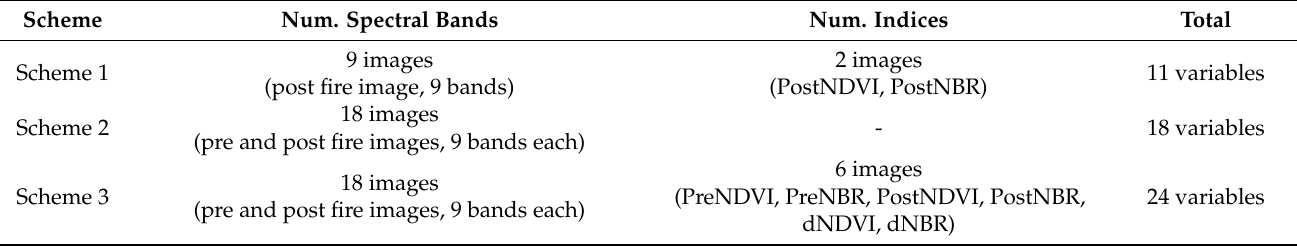
Table 3. Components of dataset by scheme.